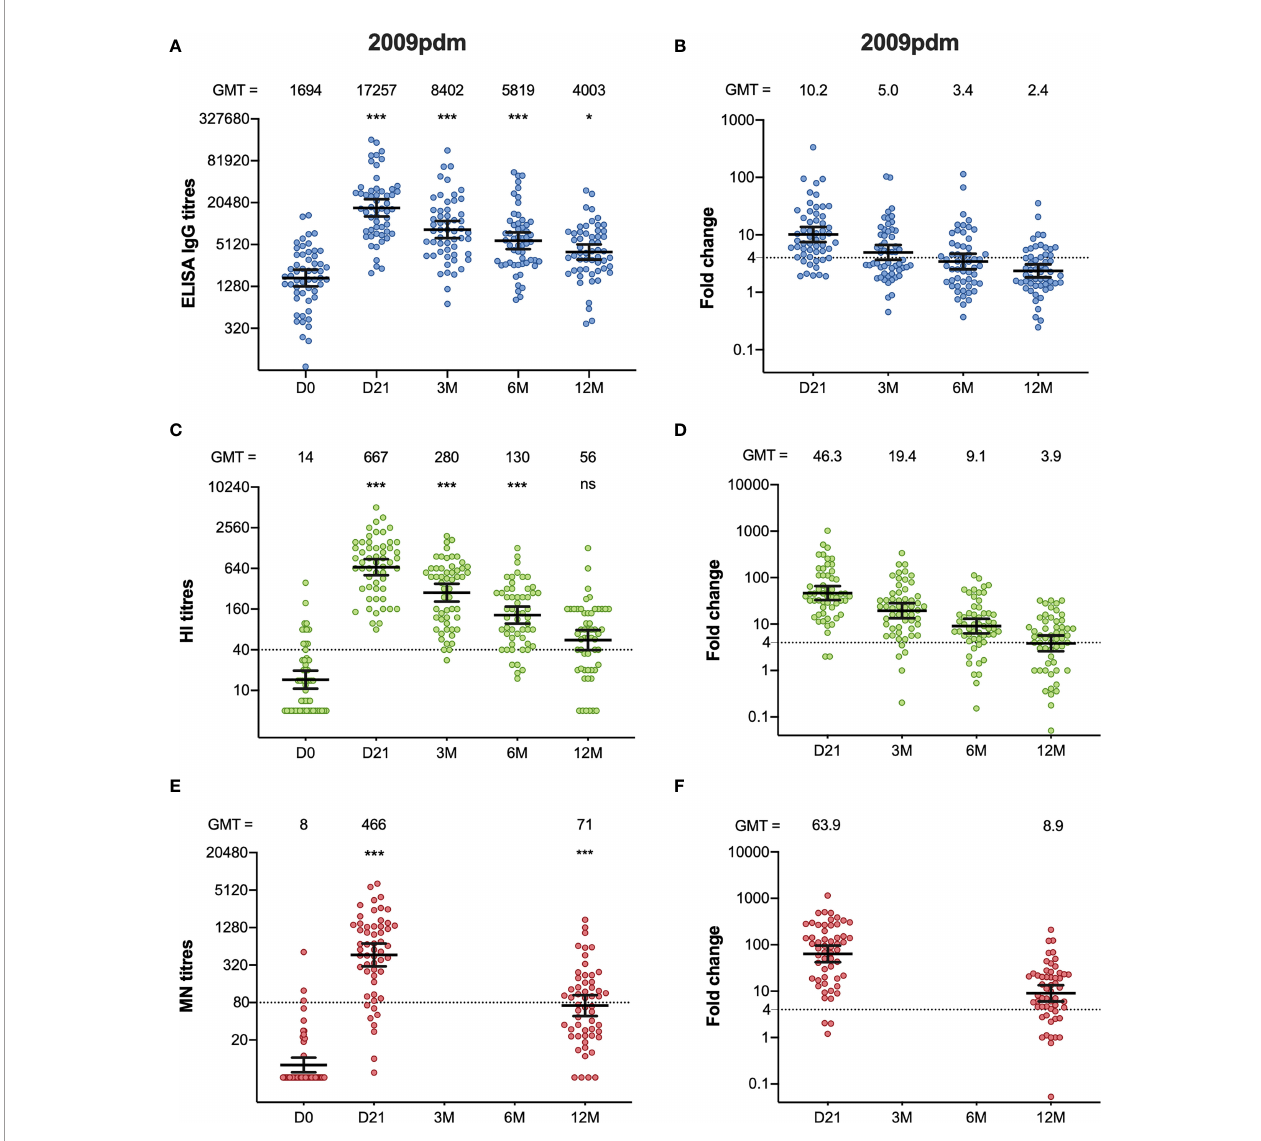
FIGURE 1 | The H1N1pdm09-speci fi c ELISA IgG, HI, and MN antibody response after pandemic vaccination. The ELISA IgG (A) , HI (C) and MN-titres (E) measured in the HCW during 2009/10 (2009pdm). Each symbol represents an individual ELISA, HI and MN titre, and the horizontal line representing the geometric mean titre (GMT) and 95% con fi dence interval. The GMT for each timepoint in each assay is shown over the graph. The dotted line at 40 and 80 represents the protective titre, in HI and MN respectively. The fold-changes from pre-vaccination ELISA IgG (B) , HI (D) and MN titres (F) measured from pre-vaccination titres (D0) to post- pandemic vaccination (D21, 3M, 6M, 12M) are shown. Each symbol represents an individual ELISA IgG, HI and MN fold-change from pre-vaccination titres to day 21, 3, 6 and 12 months after vaccination. The horizontal line shows the geometric mean with 95% con fi dence interval. The dotted line at 4 indicates seroconversion, and the GMT is shown above the graph. Statistical differences were tested using the Friedman test, with Dunn ́ s multiple comparison test. The stars indicate signi fi cant differences from pre-vaccination titres, using D0 as a reference. ***P < 0.001, *P < 0.05. Ns, not signi fi